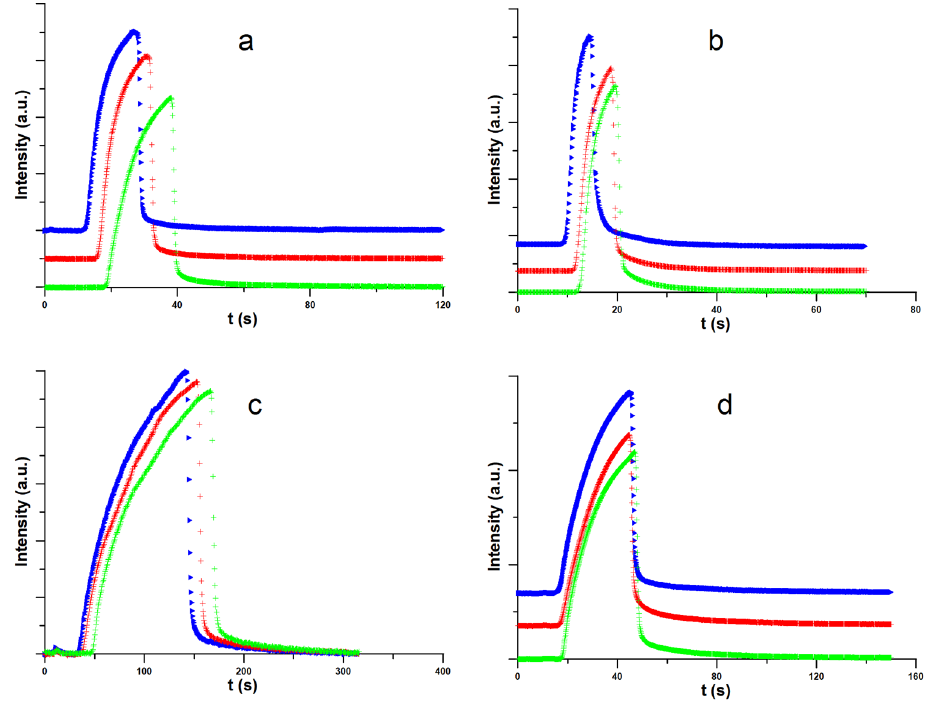
Figure 3. Chromatograms of dosed 0.2µl n-decane (( a ) 333 K; ( b ) 353 K) and 0.2µl pentadecane (( c ) 373 K, ( d ) 398 K), without (green lines) and after the injection of 1 µl (red line) and 2 µl (blue line) of water.